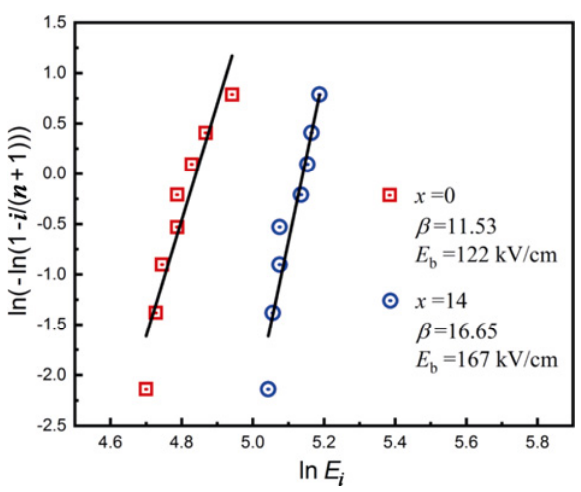
Fig. 9 Weibull distributions of breakdown strengths of BS 0.5 BNT ceramics and BS 0.5 BNT–14GS ceramic